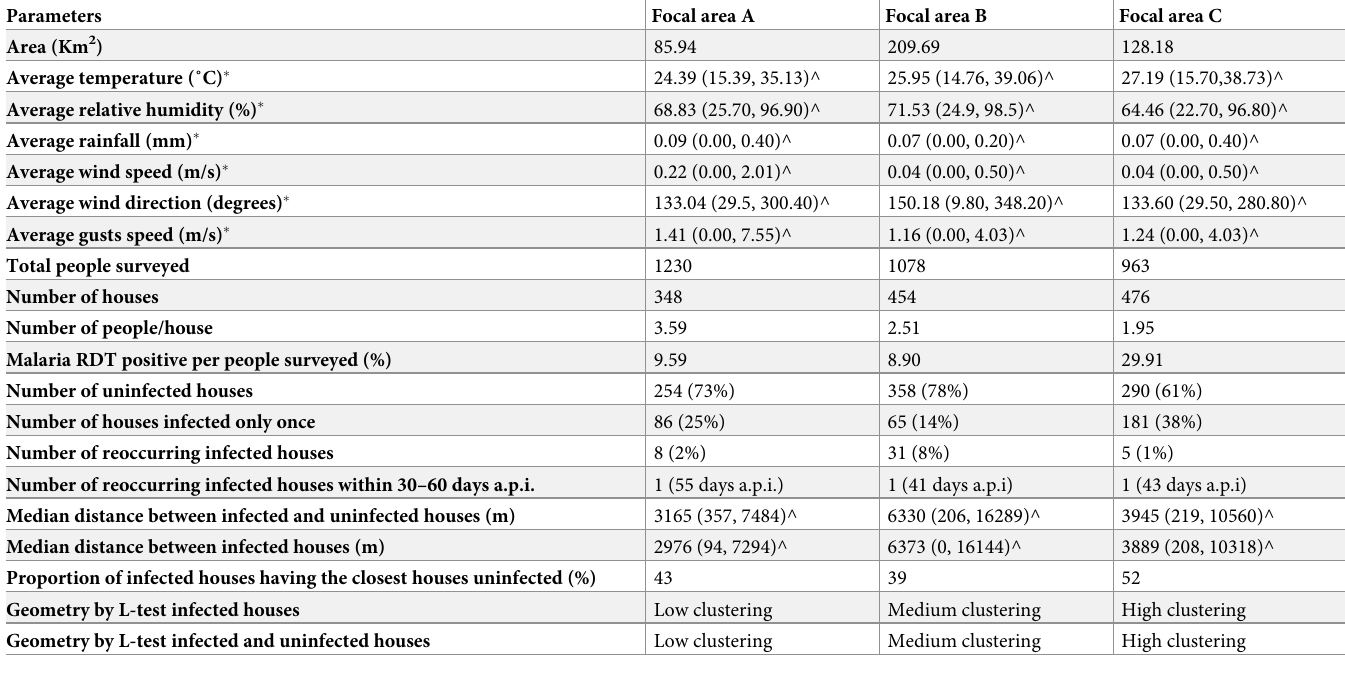
Table 1. Environmental and epidemiological characteristics of focal areas for the period under study (1 st July 2016 to 12 th May